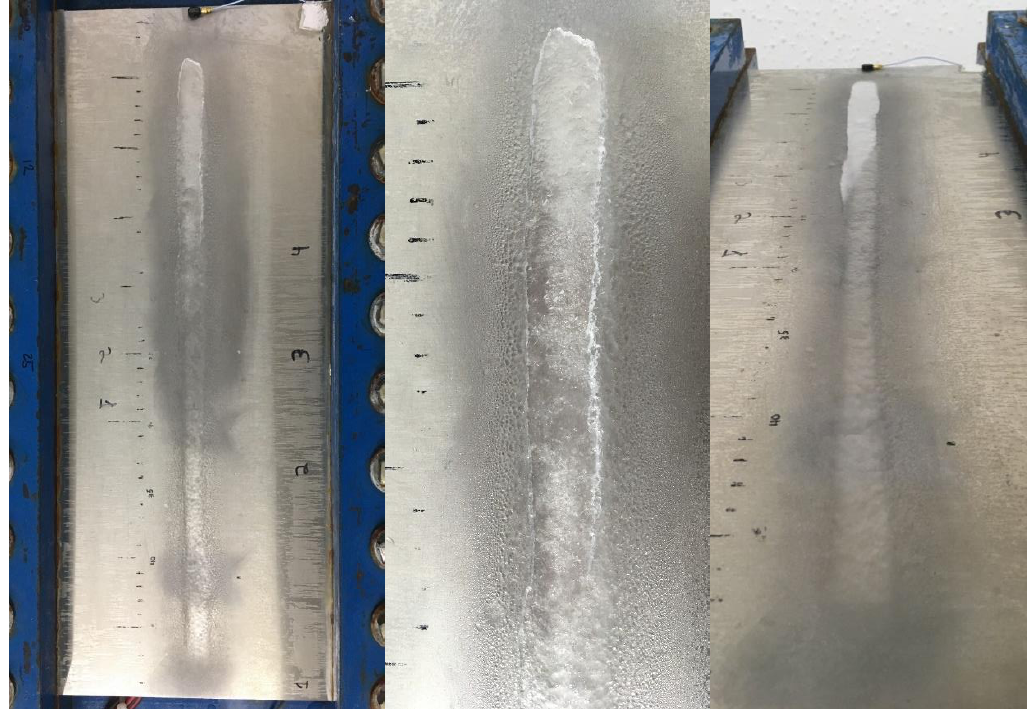
Figure 14. Delamination of the ice at 550 Vpp in steady-state activation with all piezoelectric actuators activated in phase at 188 Hz.